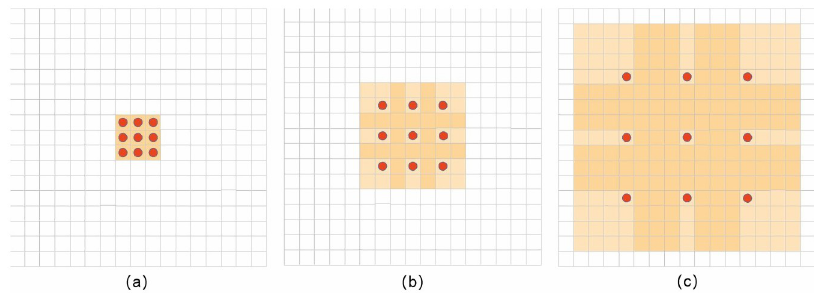
Fig 1. Improved DeepLab network. (a) is an ordinary 3 × 3 convolution kernel, which can also be understood as the void convolution with dilation rate = 1 and is a special form of the void convolution. (b) is a void convolution with a dilation rate = 2. Based on the ordinary 3 × 3 convolution kernel, it expands a 3 × 3 convolution kernel into a 7 × 7 convolution kernel by adding empty points with a weight of around nine points, thereby increasing the receiver field. (c) Similarly to (b), it has a dilation rate = 4 and expands the 3 × 3 convolution kernel to 15 ×